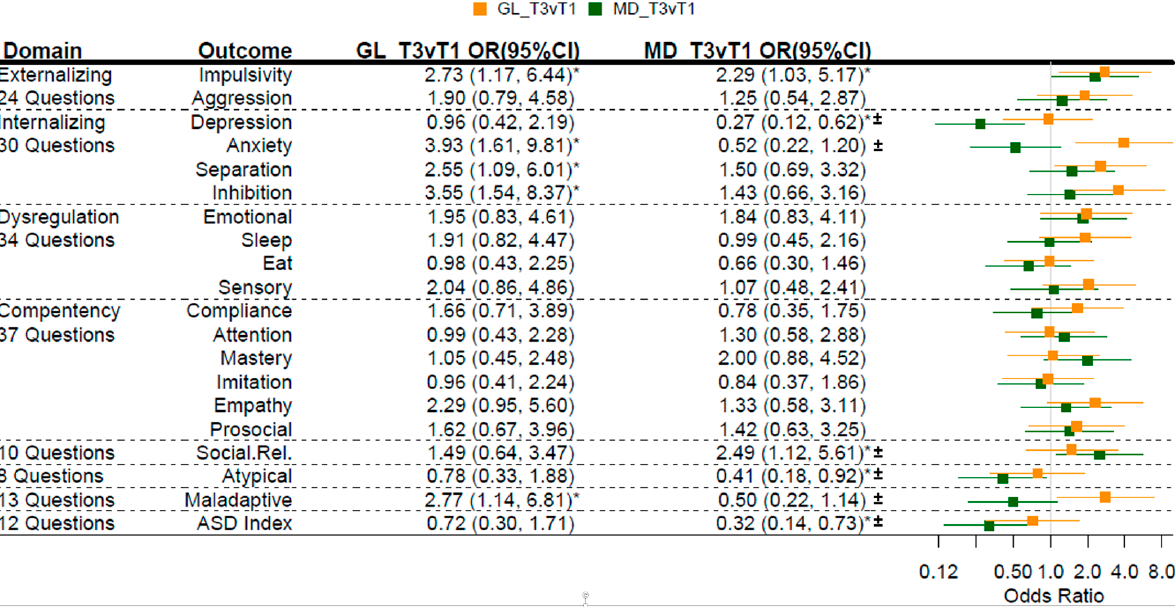
Figure 4. Sex-specific associations of MGL and offspring imprint control region methylation. Sex-specific associations of ICRs and MGL diet. Tertiles of MGL were assessed for associations with mean methylation values at known imprint control regions. For example, each tertile of MGL was associated with a 1.38% increase in mean methylation at the SGCE/PEG10 ICR. Estimates were adjusted for maternal fiber intake, total energy intake, self-reported race, smoking status, diabetes status, folate intake, age, obesity status, education, as well as paternal age and child birth weight, preterm status, and parity. * p < 0.05.